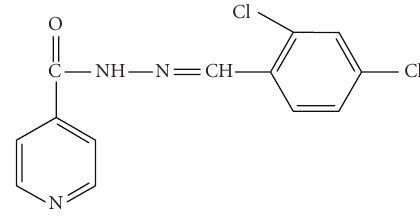
Figure 1: N-isonicotinamido-2 (cid:2) ,4 (cid:2) -dichlorobenzaladimine (INH-